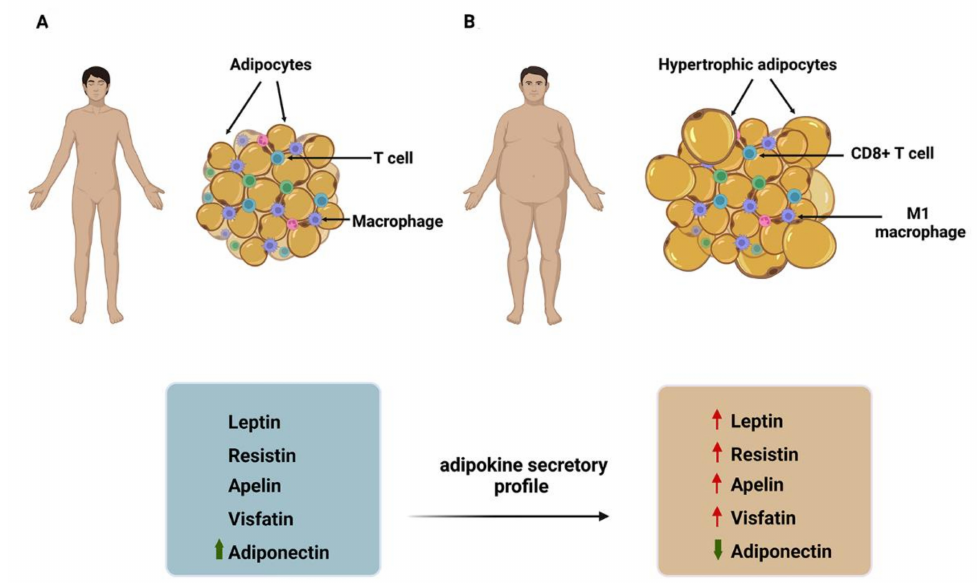
Figure 1. Changes in adipose tissue during obesity. ( A ) Adipose tissue of normal-weight individuals, ( B ) changes in adipose tissue occurring in obesity. During obesity, adipose tissue expansion occurs, characterized mainly by adipocyte hypertrophy. At the cellular level, a change in the secretory profile of adipokines has been reported, highlighting a decrease in adiponectin and an increase in leptin, resistin, apelin, and visfatin. The four short isoforms contain a conserved box1 motif involved in JAK2